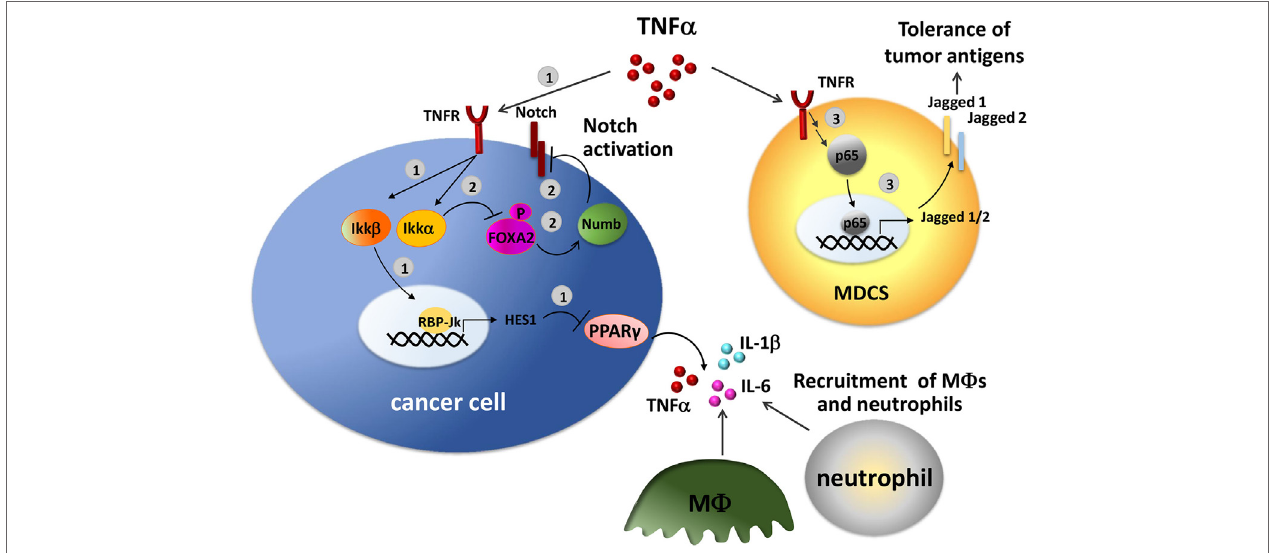
FiGURe 3 | Crosstalk between Notch and tumor necrosis factor α (TNF- α ) in the tumor environment. TNF- α induces Notch activation through NF- κ B pathway in tumor cells. 1. TNF- α activates Ikk β inducing the expression of the Notch target gene HES1. HES1, in turn, inhibits the expression of the anti-inflammatory receptor peroxisome proliferator-activated receptor γ (PPAR γ ) with a consequent increased production of TNF- α , IL-6, and IL-1 β , that recruit macrophages and neutrophils in the tumor site (135). 2. TNF- α promotes Notch signaling by activating Ikk α , that in turn phosphorylates and inhibits FOXA2, thereby reducing the transcription of the target gene Numb, a Notch repressor (136). 3. In tumor-infiltrating myeloid-derived suppressor cells (MDSCs), NF- κ B-p65, a key mediator of TNF- α /TNFR signaling, transactivates Jagged1 and 2 promoters and induces their expression stimulating the tolerogenic activity of tumor-associated MDSCs